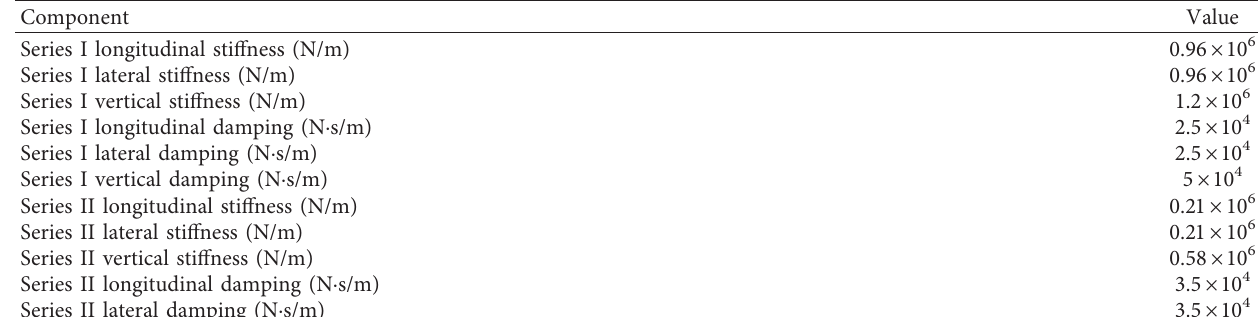
Table 4: Series I and II suspension parameters.